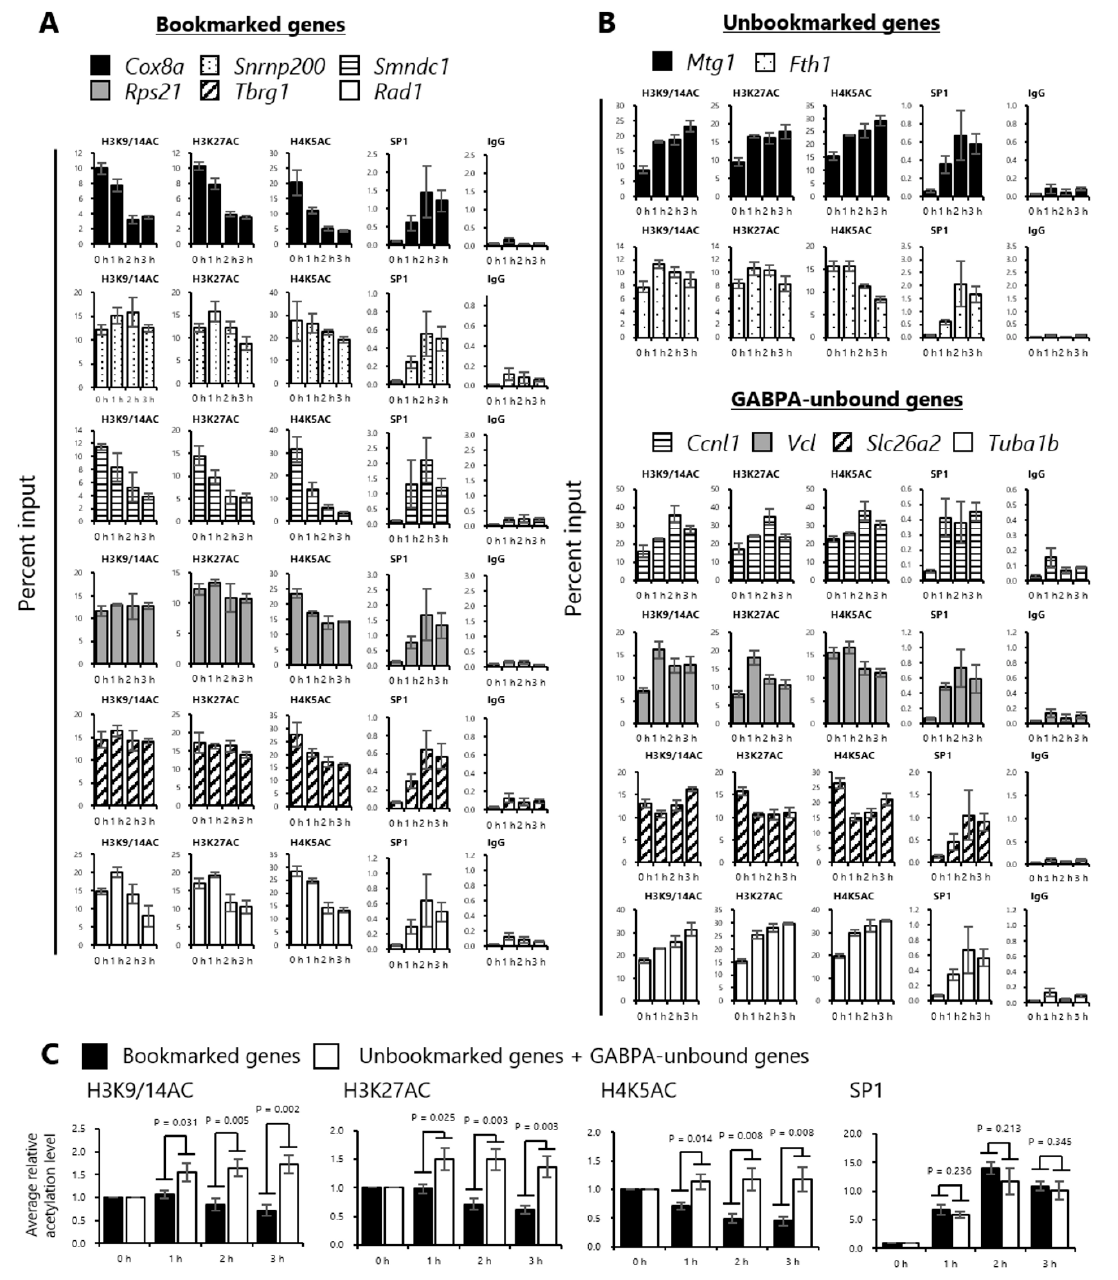
Figure 3. Histones at the sites bookmarked by GABPA are deacetylated during the M/G1 transition. ( A , B ) Histone acetylation and SP1 binding in cells at indicated time points after release from mitotic synchronization. Mitotic-arrested tsFT210 cells were released and harvested at indicated time points, then subjected to chromatin immunoprecipitation assay using antibodies against H3K9/14AC, H3K27AC, H4K5AC, and SP1, followed by quantitative PCR using primer sets specific for upstream regions of the bookmarked ( A ), unbookmarked ( B ), and GABPA-unbound genes. Normal rabbit IgG was used as a negative control. The data of 0 h are the same as those of Figures 1 and 2. Error bars denote SEM ( n = 3). ( C ) Comparison of the average relative level of each histone acetylation and SP1 binding in cells at indicated time points after release from mitotic synchronization at the bookmarked gene regions vs. those unbookmarked and GABPA-unbound gene regions. Error bars denote SEM ( n = 3). Statistical significance was analyzed using a one-tailed Student’s t -test.